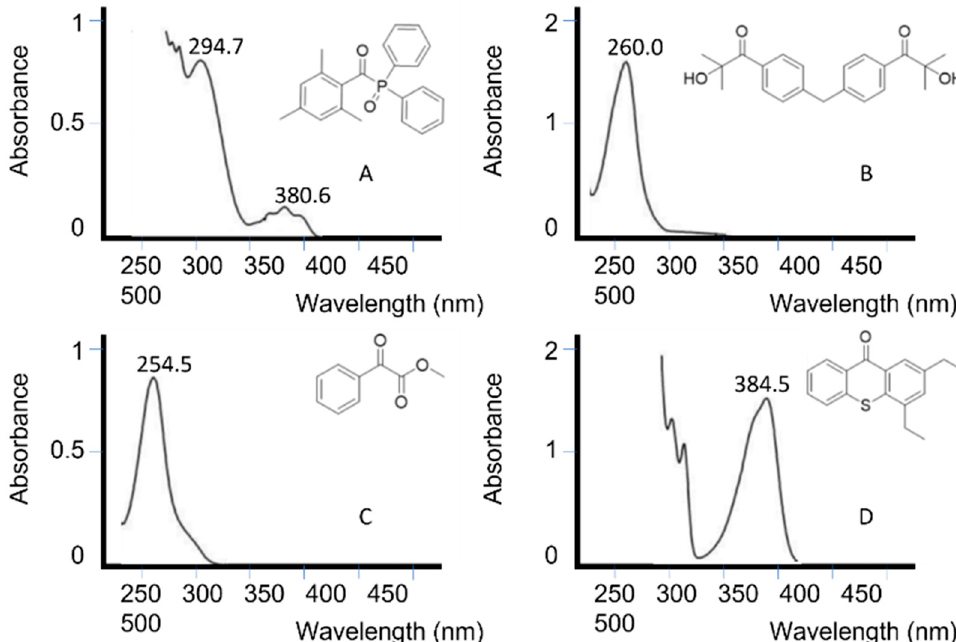
Figure 7. Absorption spectra of two unimolecular photoinitiators ( A , B ) and two bimolecular pho- toinitiators ( C , D ) dissolved in acetonitrile at a 0.01% mass fraction [121].